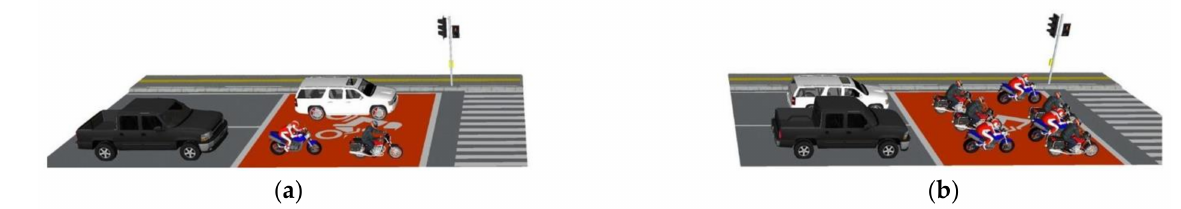
Figure 5. ( a ) Red box occupied by four-wheeled vehicles; ( b ) red box occupied by motorcycles only. Next, in data collection, the volume of motorcycles that violate the stop lane during the red-light phase was calculated manually by a traffic counter based on video footage. Stop line violation is when motorcycles wait at the red light and stop in front of the stop line. One indicator that shows that the red box is effectively implemented is when no motorcycle stops in front of the stop line. The red box can change the behavior of motorcyclists who initially tend to violate the stop line to not violate the stop line because there is a waiting area for motorcycles in the red box. To illustrate the stop line violation by motorcycles, see Figure 6.